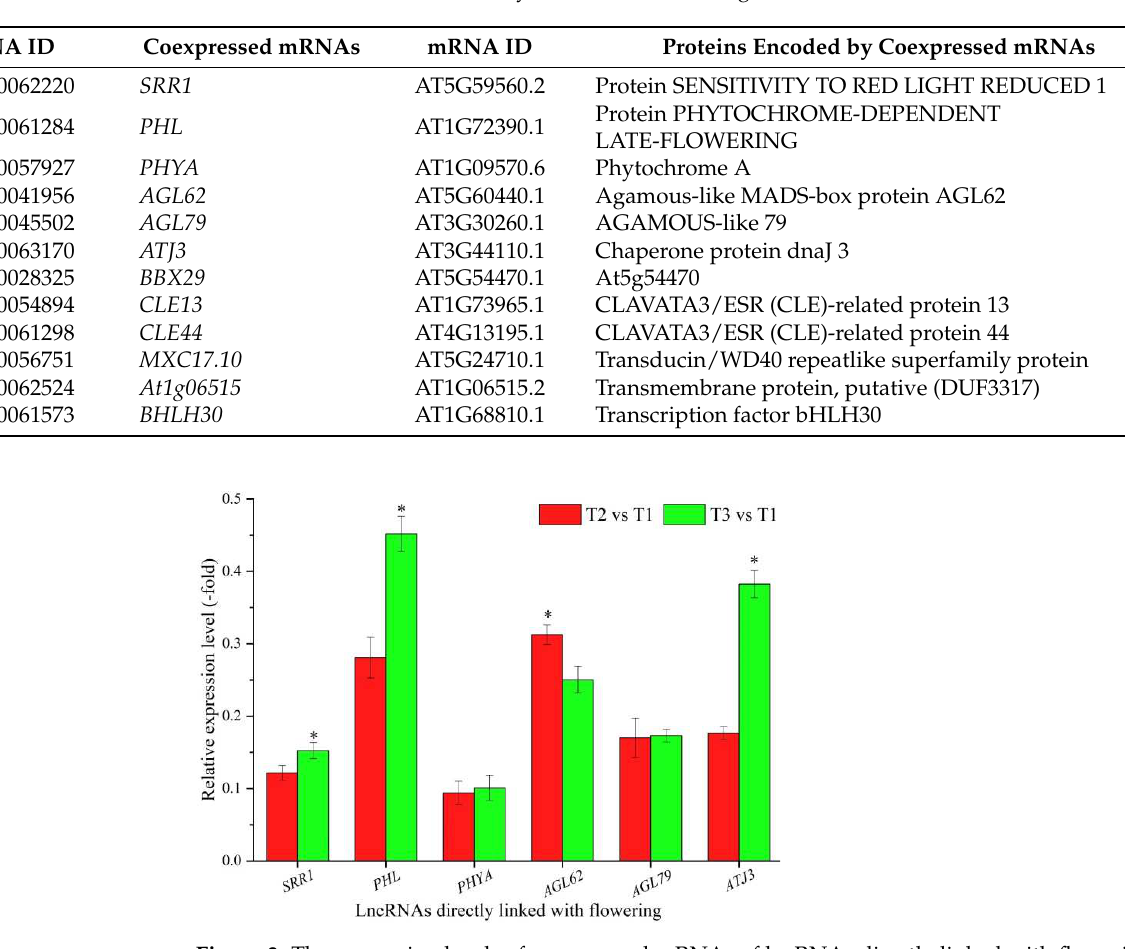
Figure 3. The expression levels of coexpressed mRNAs of lncRNAs directly linked with flowering in A. sinensis at T2 vs. T1 and T3 vs. T1, as determined by qRT-PCR. The “*” represents a significant difference at p < 0.05 level between T2 vs. T1 and T3 vs. T2 for the same gene. Table 4. Fourteen lncRNAs directly linked with temperature